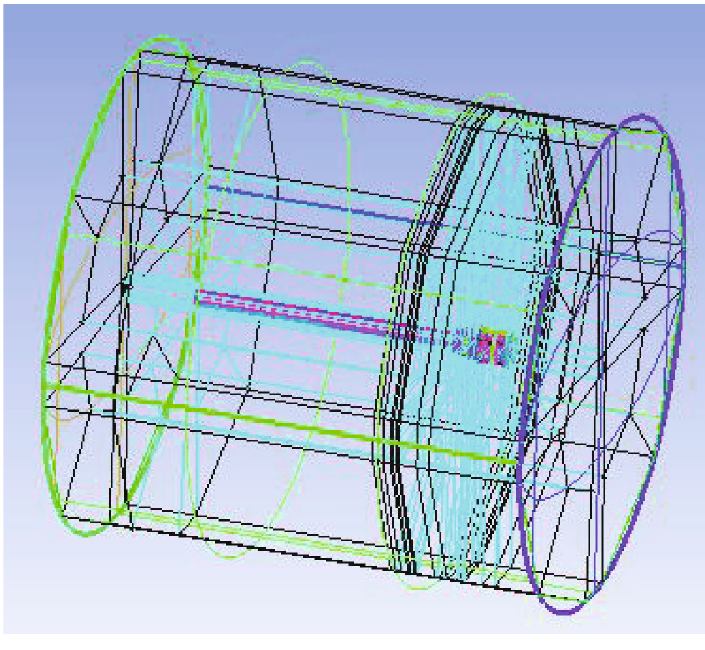
Figure 5: The line graph of submunition ’ s blocking.